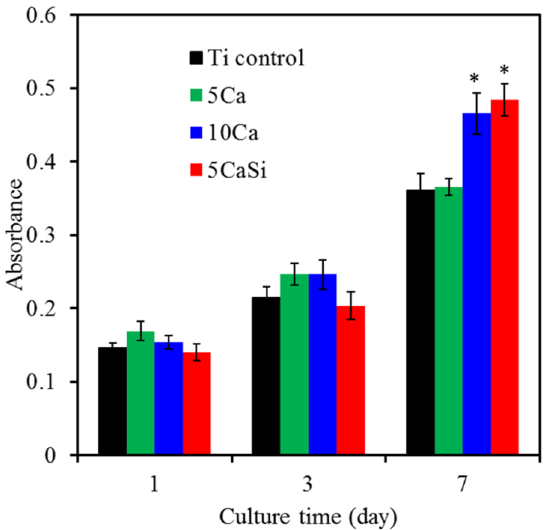
Figure 9. MTT assay for cell viability of MG63 cultured on the various samples after 1, 3 and 7 days of incubation. * Statistically significant difference ( p < 0.05) from the Ti control.